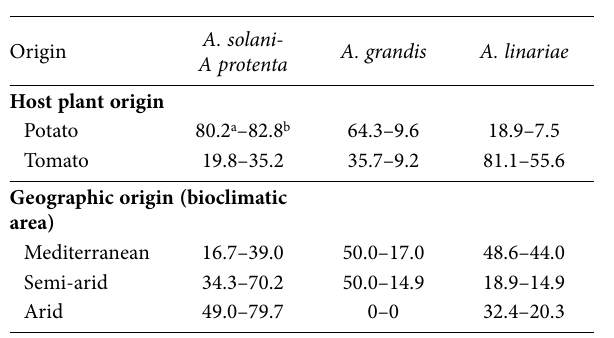
Table 2. Frequencies of the four large-spored Alternaria species according to the host plants (potato and tomato) and to the geo- graphical locations